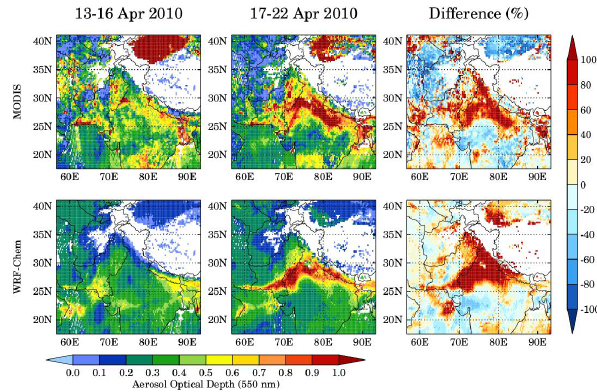
Fig. 10. Spatial distributions of aerosol optical depth at 550nm retrieved by MODIS aboard Aqua (top panels) and simulated by WRF-Chem (bottom panels) during 13–16 April (low dust period) and 17–22 April 2010 (high dust period). Model results are co- located in space and time with MODIS retrievals and white space indicates missing data. MODIS AOD over land is from the “Deep Blue” algorithm and that over ocean is from the standard ocean al- gorithm. Percentage changes in AOD during high dust period rela- tive to low dust period are shown in rightmost